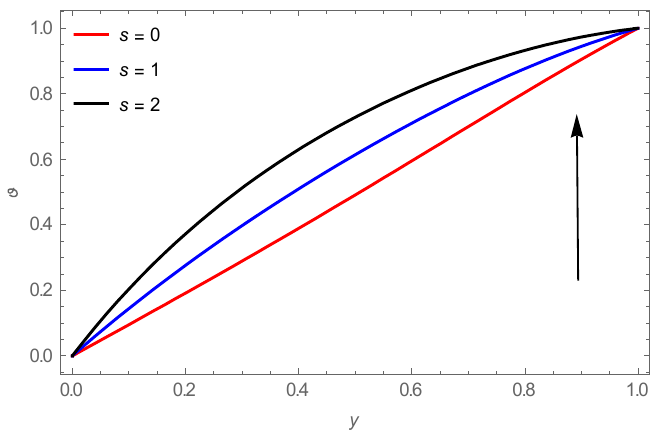
Figure 2. Impact of ω on temperature field.